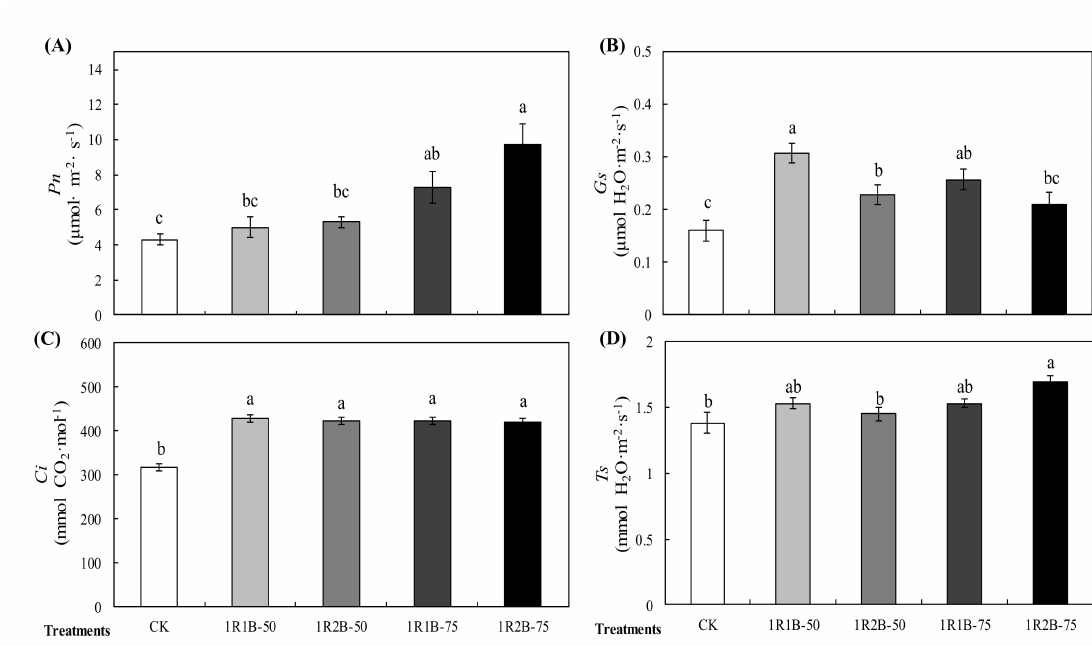
Figure 4. E ff ects of RB ratio and intensity of supplemental light on net photosynthetic rates ( A , P n ), stomatal conductance ( B , G s ), intercellular CO 2 concentration ( C , C i ), and transpiration rate ( D , T s ) of cucumber seedlings under extremely low irradiance. Di ff erent letters indicate statistically significant di ff erences among treatments (ANOVA, p ≤